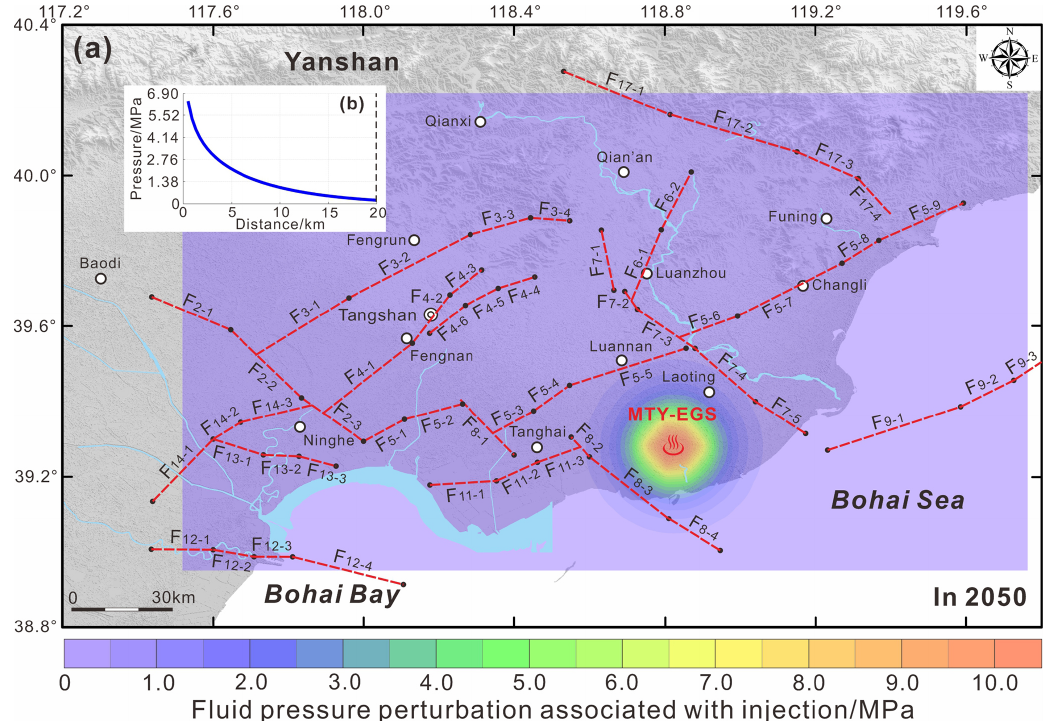
Figure 9. (a) Fluid pressure perturbations from five injection wells linearly superposed onto the mapped domain of the Tangshan seismic region in 2050. (b) Increase in fluid pore pressure above natural levels due to fluid injection in each of the five wells as a function of distance in model year